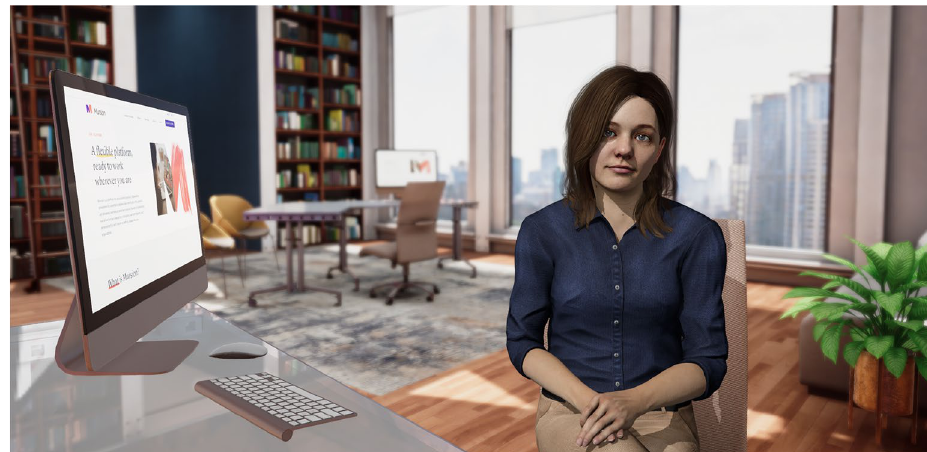
Figure 1. The immersive virtual world used to simulate a challenging conversation with a colleague, represented by an avatar in a workplace